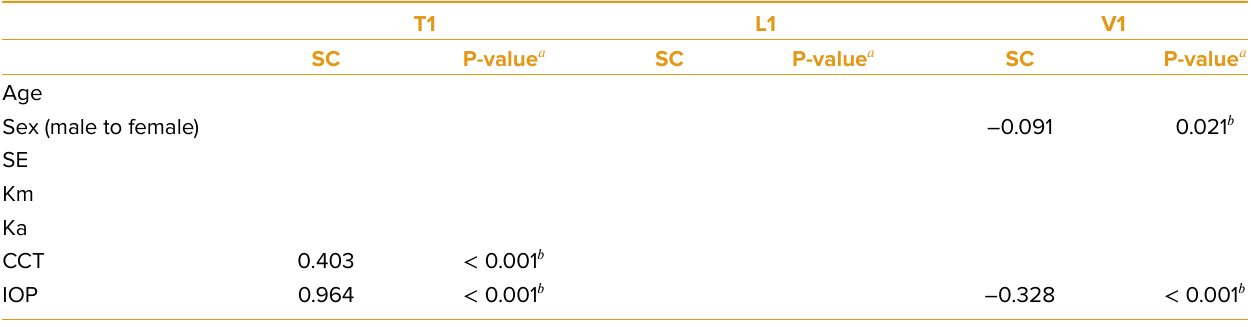
Table 3. Linear regression analysis demonstrating association between selected demographic and ocular factors to each Corvis ST parameters at the first applanation